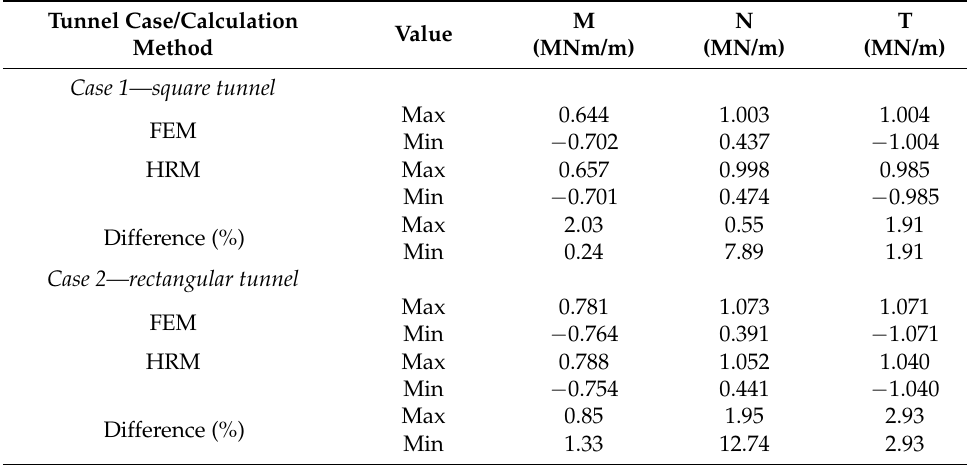
Table 2. Comparison of the internal forces by the HRM method and FEM.